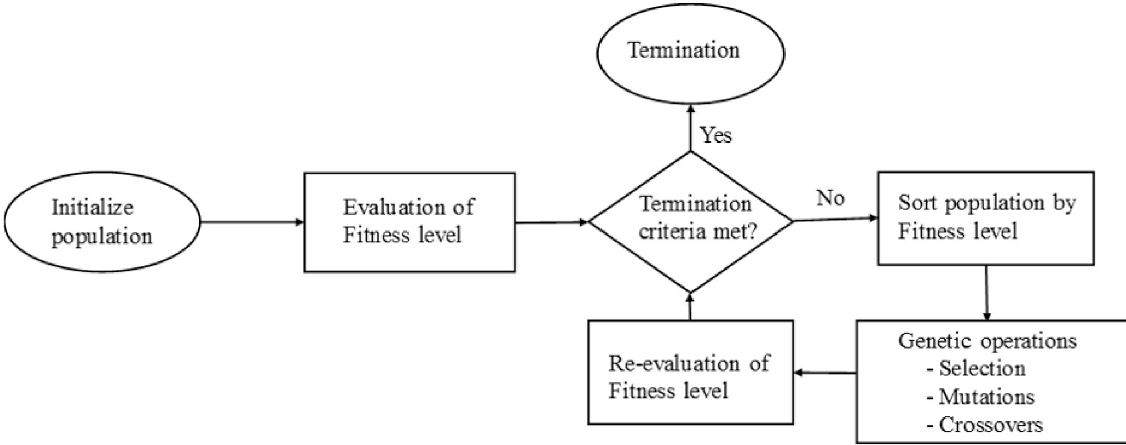
Fig 2. Typical flow chart for genetic